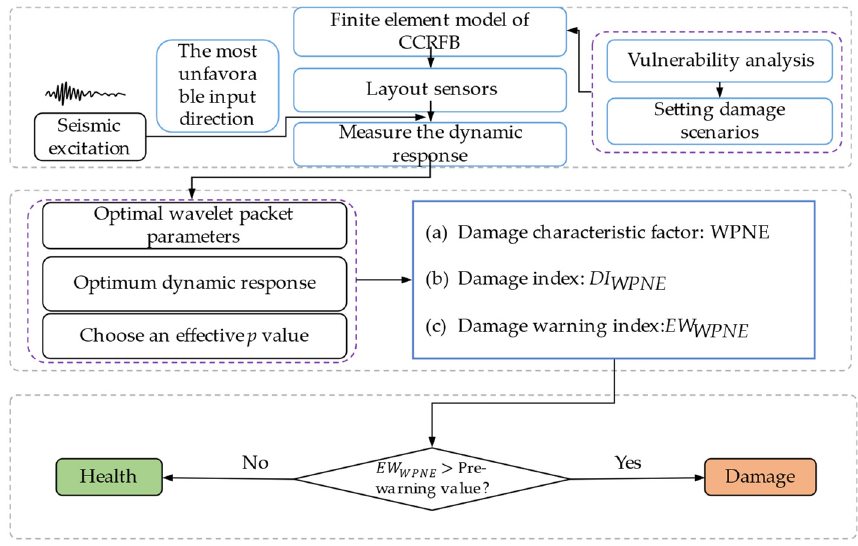
Figure 1. Flowchart of seismic damage identification for CCRFBs.